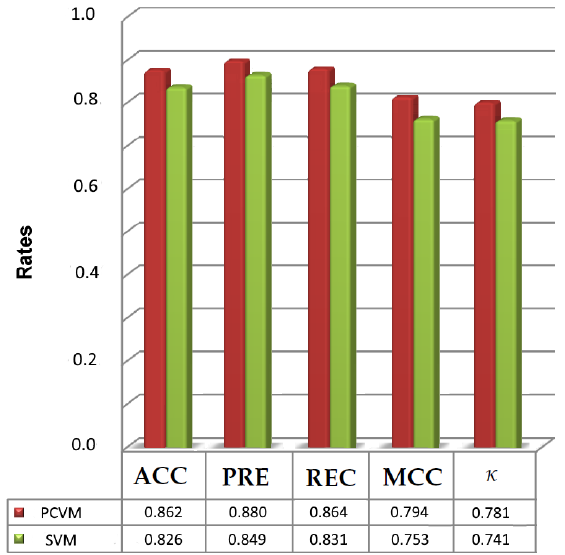
Figure 4. The maximum scores achieved for SVM and